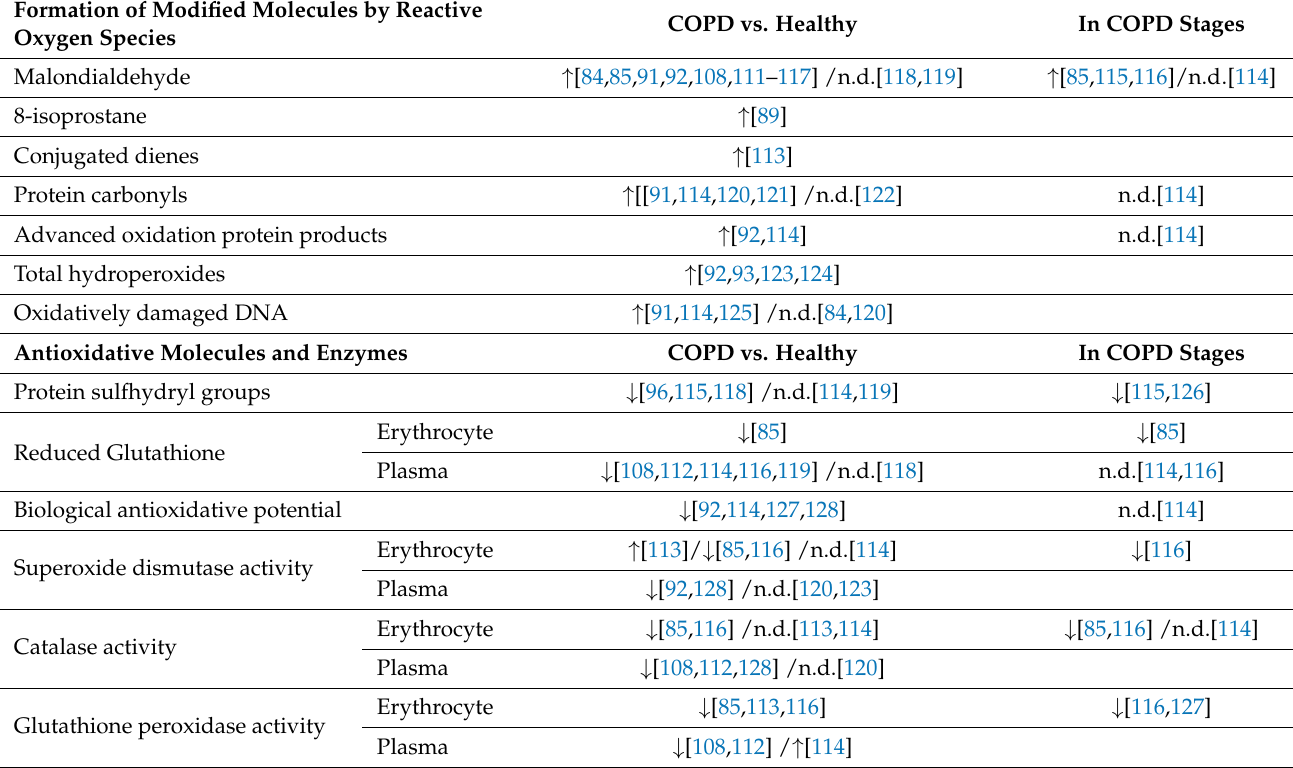
Table 1. Summary of oxidative blood biomarkers in